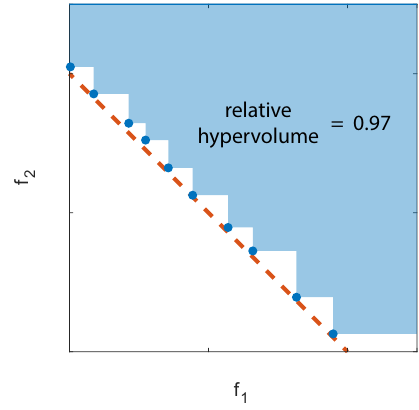
Figure 2. Example of relative hypervolume. Blue dots represent the optimal solutions computed numerically, the red dashed line the target front analytically